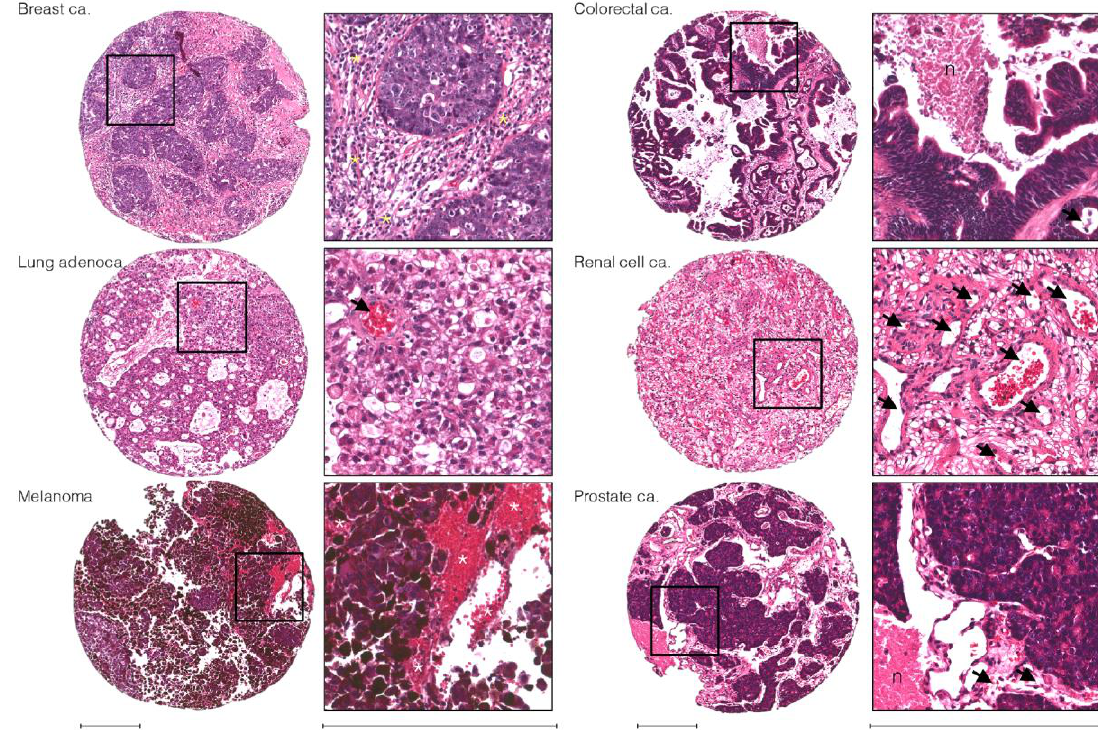
Figure 2. Typical histological appearance of brain metastases from different primary tumor types. Hematoxylin and eosin (H&E)-stained tissue sections show that brain metastases usually exhibit morphology typical of the primary tumor of origin. Features often seen in brain metastasis surgical specimens are highlighted: intact and dilated blood vessels (arrows; high microvascular density in the renal cell carcinoma-brain metastasis shown), hemorrhagic regions typical of melanoma brain metastases (white asterisks), necrotic tissue (“n”) and reactive gliosis around tumor cell nests with pushing margins (yellow asterisks). Scale bars = 250 µ m. ca., carcinoma; adenoca. adenocarcinoma. Tumor cells use remarkable mechanisms to co-opt the neural